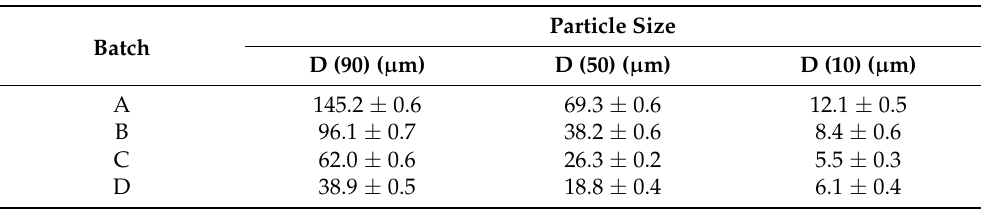
Table 4. Particle size of raw nifedipine for preparation of each batch.